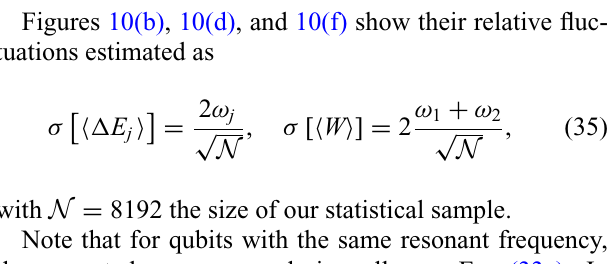
FIG. 11. (a) Experimentally observed modes of operation of the SWAP engine. (b) Theoretical